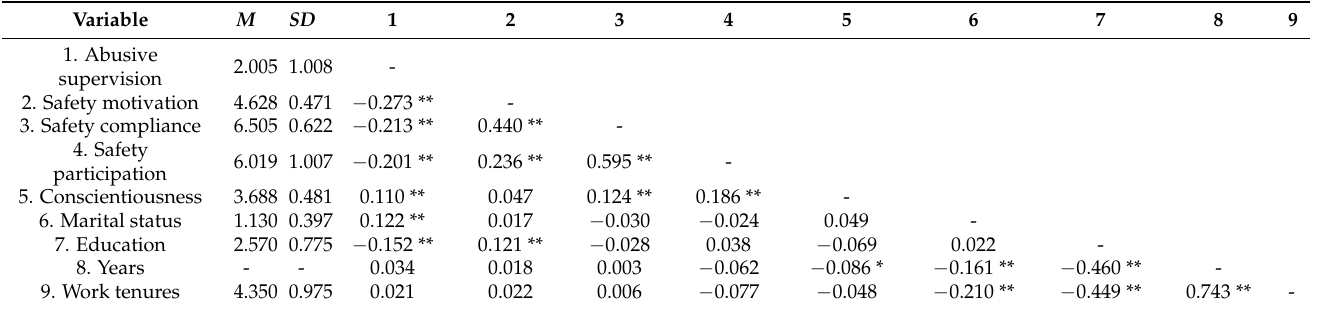
Table 2. Descriptive statistics and correlations among study variables.